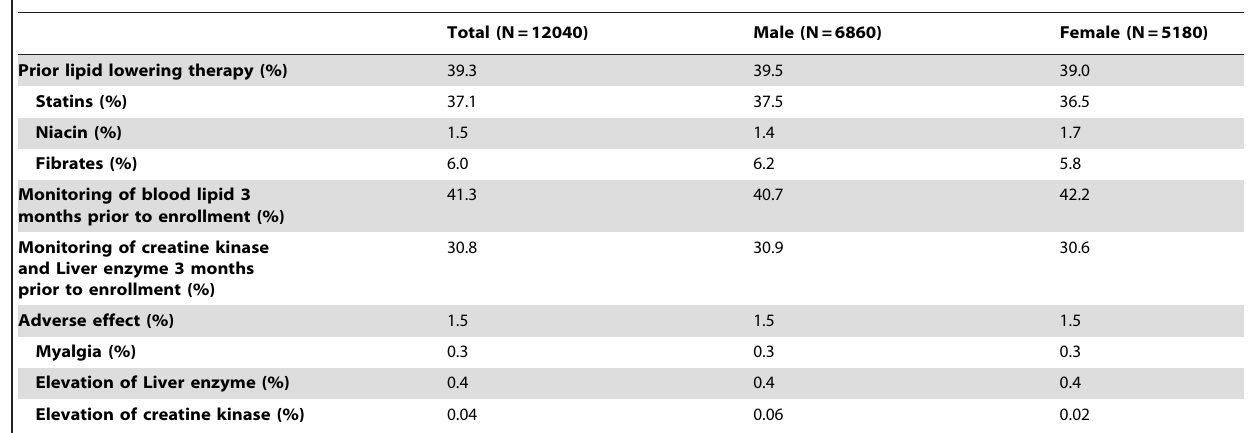
Table 2. Lipid lowering